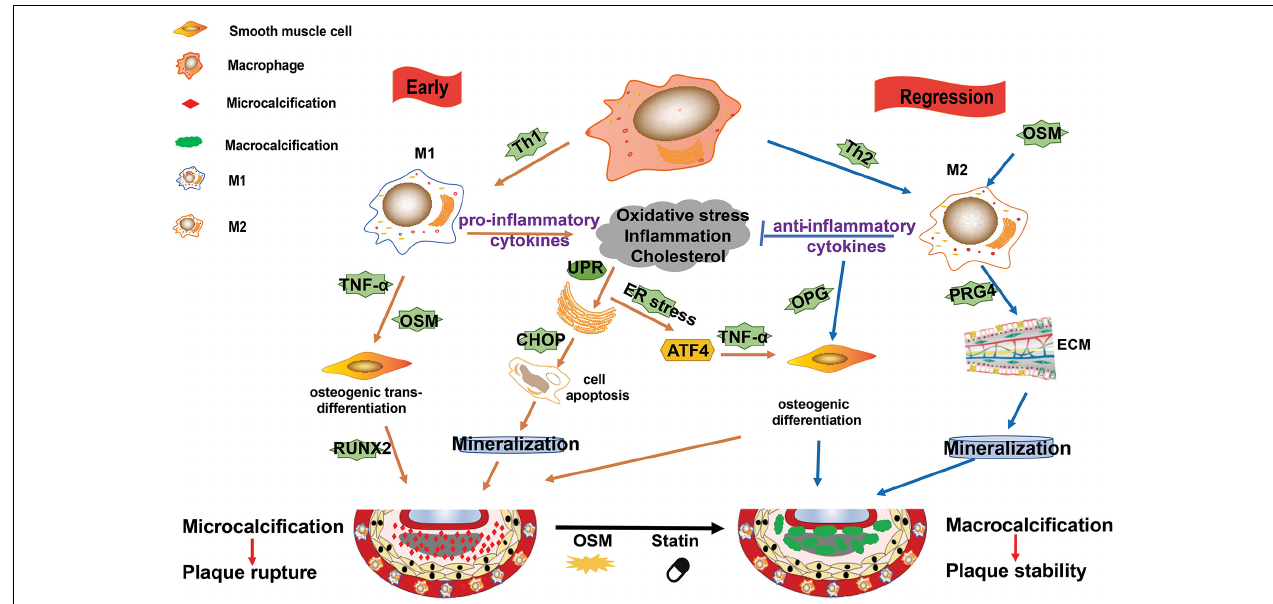
FIGURE 3 | M1/M2 macrophages and their roles in plaque calcification. Calcification occurs in both the intimal and medial layers of the artery. In the plaque microenvironment, multiple factors, such as inflammation, endoplasmic reticulum (ER) stress, osteoblastic differentiation, hyperlipidemia, and oxidative stress, drive the progression of calcification. M1 macrophages mainly contribute to microcalcification by the following ways: (1) M1 macrophages and other cells death (such as induced by ER stress) and the subsequent mineralization; (2) the pro-inflammatory cytokines and Oncostain M (OSM) secreted by M1 macrophages induce osteogenic trans -differentiation of vascular smooth muscle cells (VSMCs); and (3) ER stress promotes osteoblastic differentiation of VSMCs. M2 macrophages can induce macrocalcification by the following ways: (1) they counteract inflammation by producing anti-inflammatory cytokines such as IL-10; (2) they promote the production of extracellular matrix; and (3) they enhance osteoblastic differentiation of